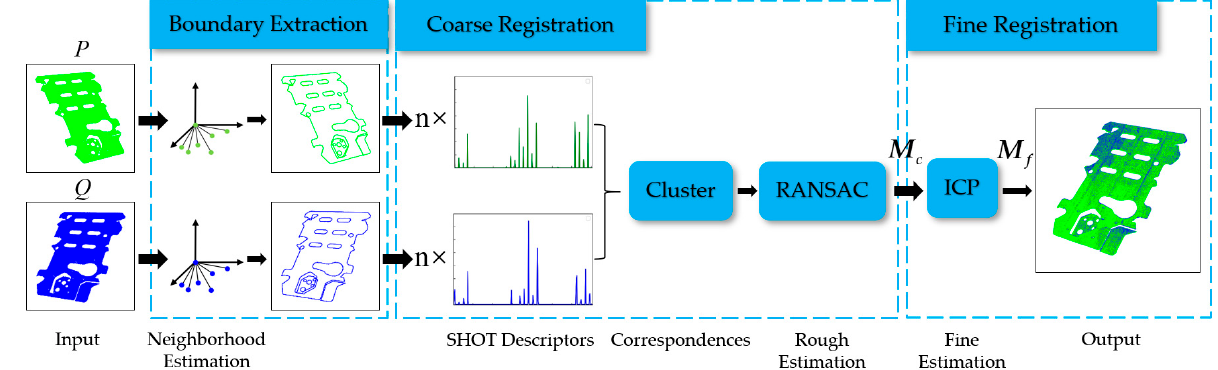
Figure 1. Flowchart of the proposed registration method for a large-scale planar point cloud.